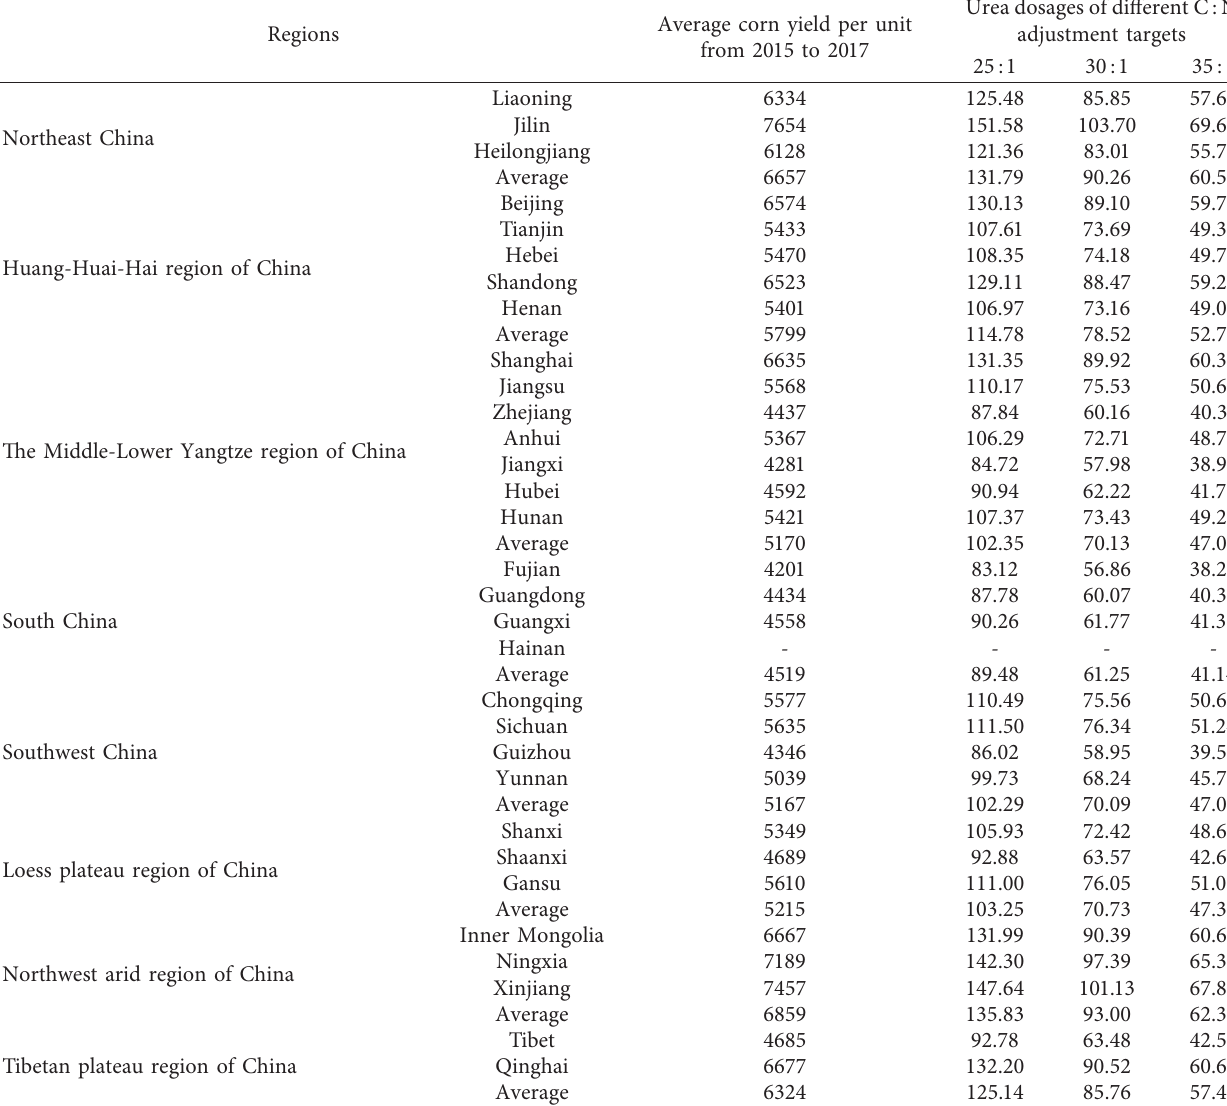
Table 11: Enquiry table for urea applied to corn straw returning to the field in all regions of China and provinces (cities, autonomous